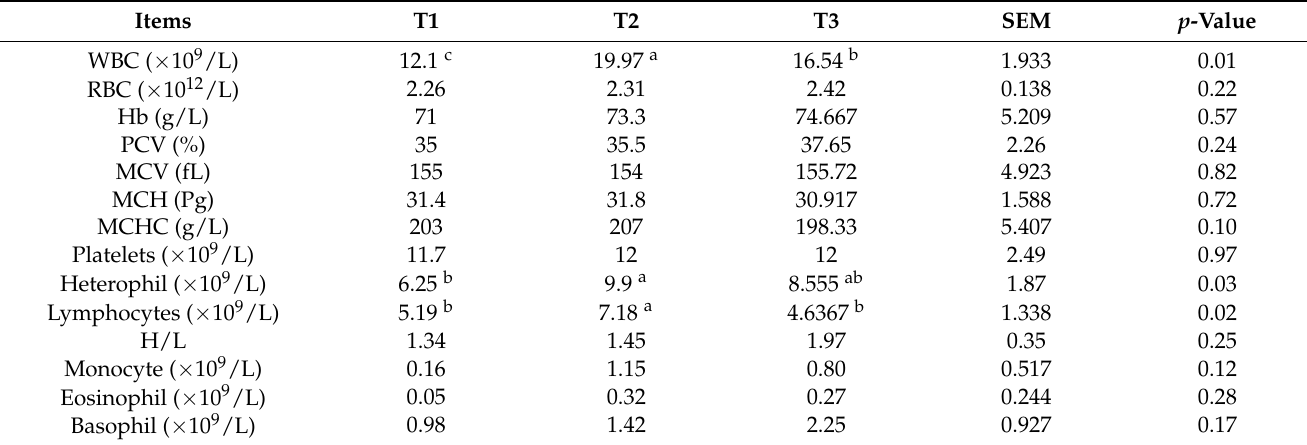
Table 5. Effects of fructooligosaccharides on hematology indices of laying